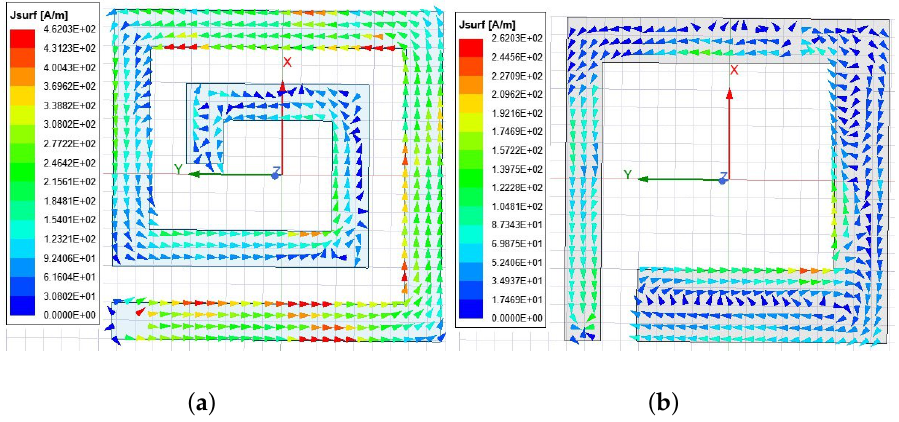
Figure 2. Current distributions of the proposed antenna at 403 MHz. ( a ) Top radiation patch layer; ( b ) middle radiation patch layer.